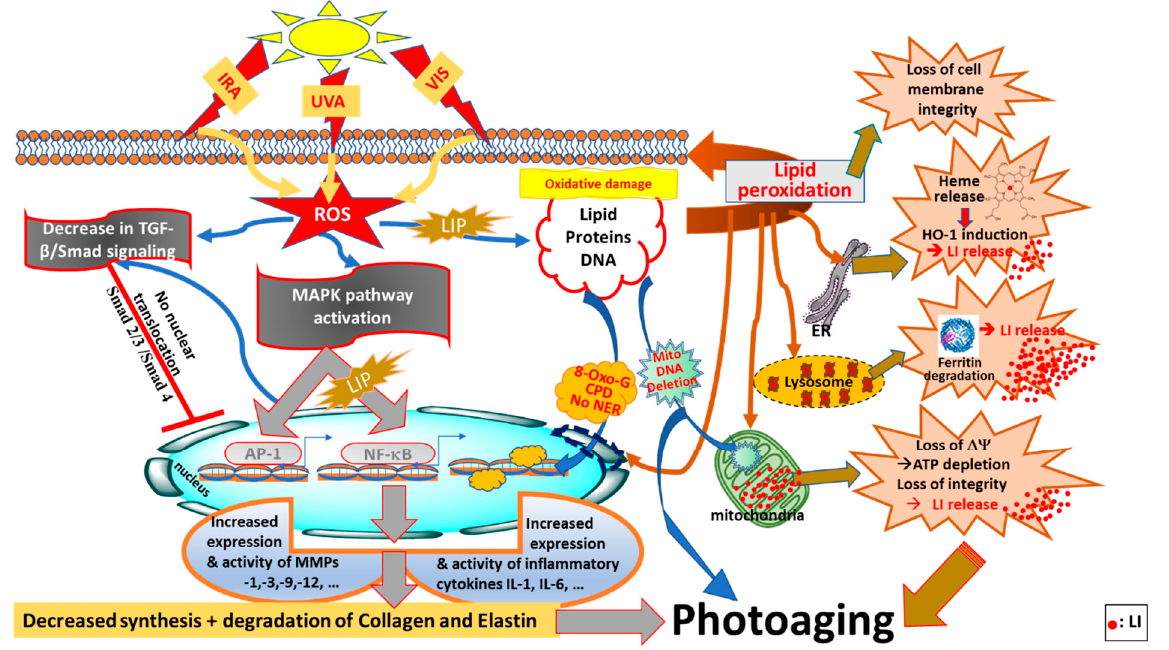
Figure 2. Photoaging pathways through disruption of redox- and iron-homeostasis by oxidising components of sunlight (UVA, VIS, IRA). ROS (reactive oxygen species) generated by oxidising components of sunlight, notably UVA, can activate the MAPK (mitogen-activated protein kinase) and NF- κ B (nuclear factor kappa B) signaling pathways, as well as AP-1 (activator protein 1) and NF- κ B transcription factors leading to increased expression of proinflammatory cytokines (e.g., Interleukins IL-1 β and IL-6) and MMPs (matrix metalloproteinases) that contribute to photoaging by changing concomitantly the composition of ECM (extracellular matrix) components by breaking down the collagen and elastin networks and regulating the TGF- β /Smad (tumour growth factor-B/Smad) signaling pathway to reduce collagen production. UVA-induced increase in LIP (labile iron pool) is also a major contributor to NF- κ B activation and the related inflammatory response. Concomitantly with this, ROS generated by oxidising components of sunlight can regulate the TGF- β /Smad (tumour growth factor-B/Smad) signaling pathway to reduce collagen production, and ultimately accelerate skin photoaging. The presence of LIP in different compartments of cells, notably cytosol, lysosomes and mitochondria, makes the skin cell constitutents (i.e., lipid, protein and DNA) highly vulnerable to iron-catalysed ROS damage leading to lipid peroxidation, oxidative DNA 8-oxo-G (8-hydroxy guoanosine adducts) and CPDs (cyclopyrimidine dimers), and for mitochondrial DNA as deletions and finally for proteins as oxidation and degradation. The UVA-induced increase in cytosolic LIP also occurs as a result of proteolytic degradation of ferritin and release of heme from ER (endoplasmic reticulum) and activation of HO-1 (heme-oxygenase 1), all of which disrupt the cellular redox (and iron) homeostasis, leading to photoaging (taken and modified from references [5,78,112–114]).